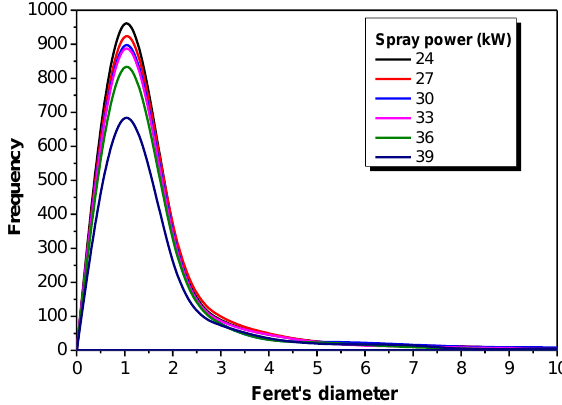
Figure 8. Feret’s diameter at different spray powers.